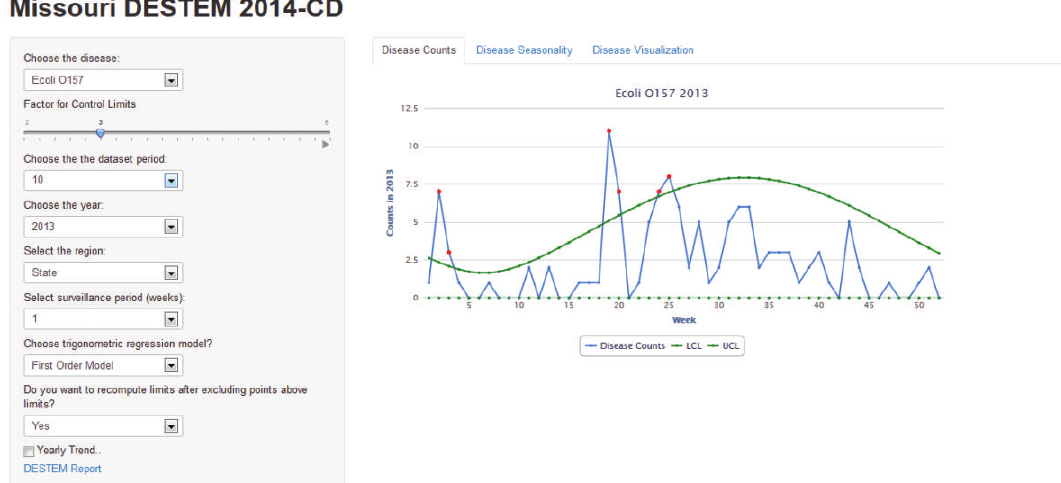
Figure 3: E. coli O157:H7 infections for the year 2013 with the upper control limits computed using the first-order trigonometric model in